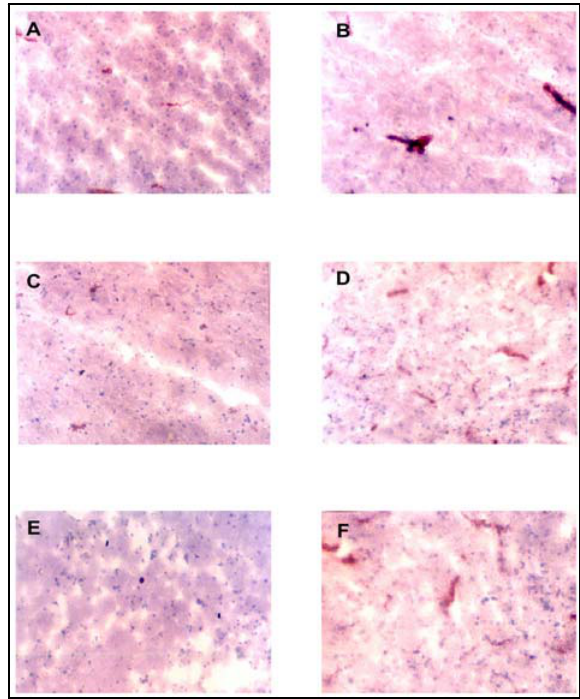
Figure 2A-F (original